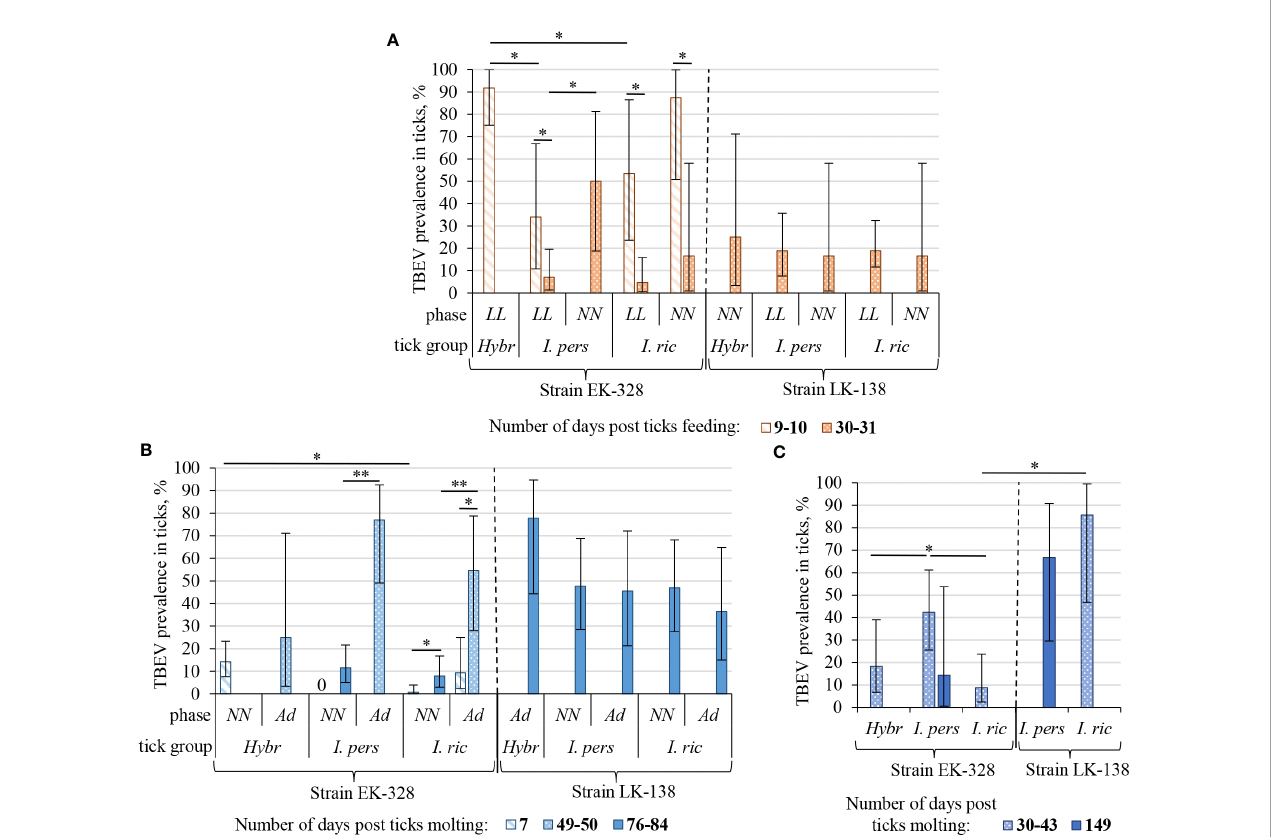
FIGURE 2 Prevalence of TBEV in I. ricinus ( I. ric ), I. persulcatus ( I. pers ), and hybrid ( Hybr ) ticks at different period after feeding/molting: (A) in engorged larvae (LL) and nymphs (NN) after feeding on infected mice; (B) in questing nymphs (NN) and adults (Ad) after fi rst molting; (C) in adults after second molting. Data for the strains EK-328 and LK-138 are separated with dashed line. Engorged larvae and questing nymphs were studied in pools of three, others – individually, TBEV prevalence in a pool of ticks was calculated using a maximum likelihood estimator with the assumption of 100% test sensitivity and speci fi city on the EPITOOLS web platform (Sergeant, 2018). Whiskers show 95% con fi dence interval of the infection rate; signi fi cant differences between groups according to Fisher ’ s exact test/chi-square test: * p<0.05, **